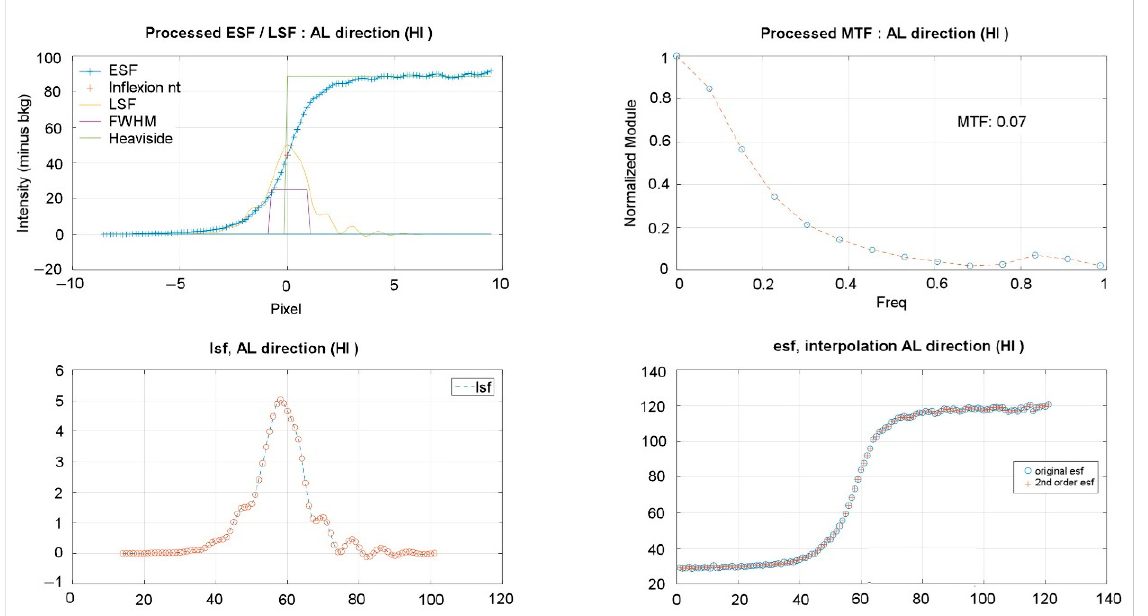
Figure 5. The output graphs of the MTF processing.